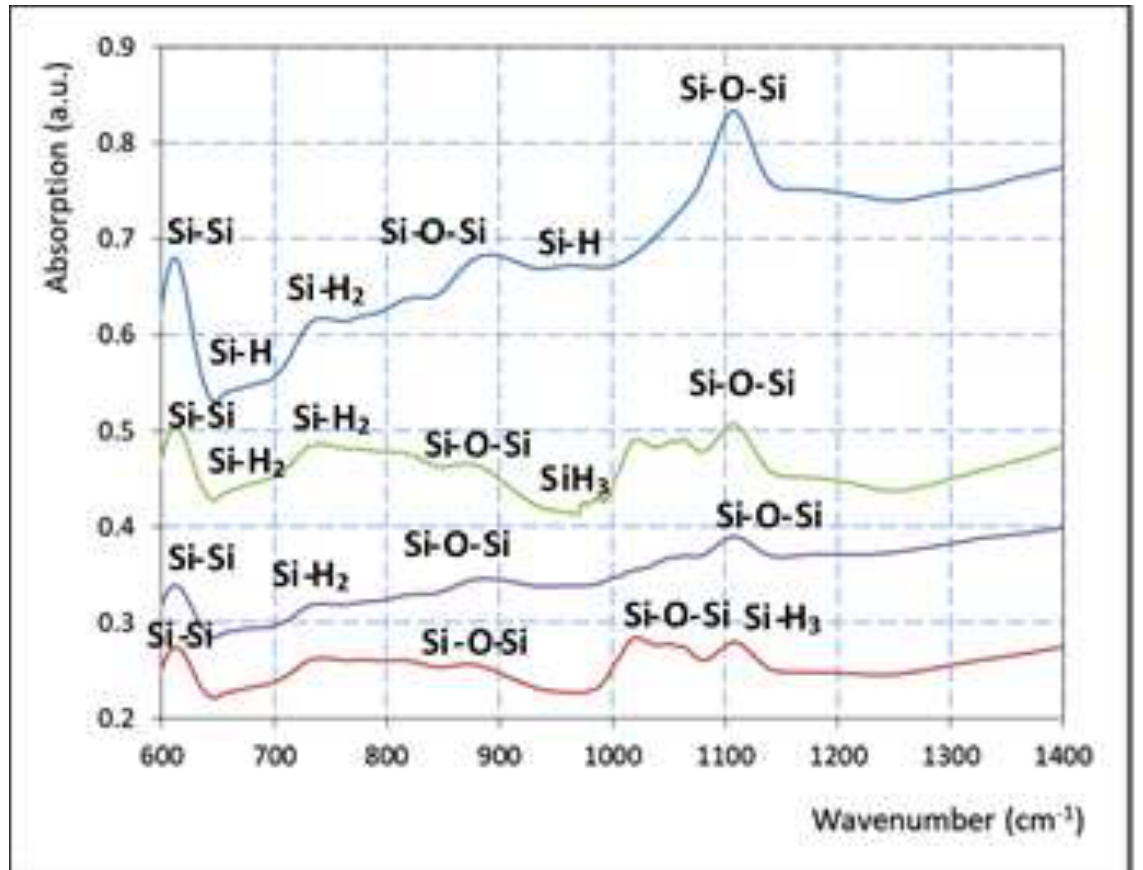
Figure 5: FTIR absorption spectra of PSi prepared in different laser intensity; a) 10 mw/ cm 2 ,b) 15 mw/ cm 2 , c) 20 mw/ cm 2 and d) 25 mw/ cm